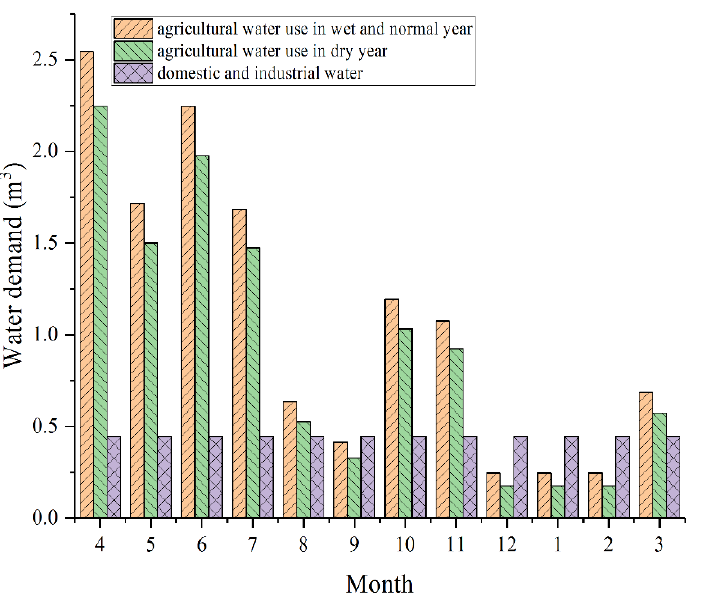
Figure 5. The downstream of the Liujiaxia Reservoir water supply for domestic, industry, and agricultural use in a wet year, normal year, and dry year.